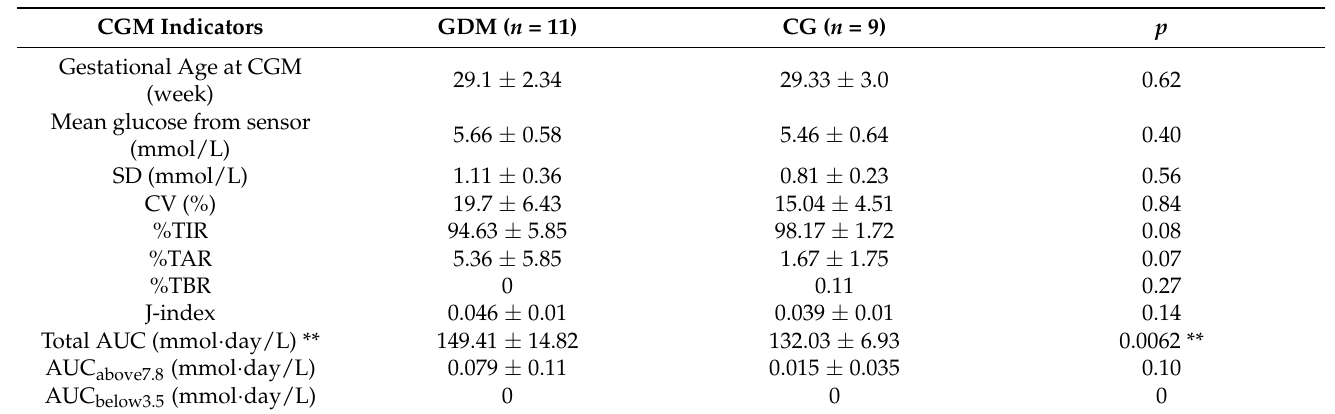
Table 3. Glycaemic variability in pregnant women GDM/CG.